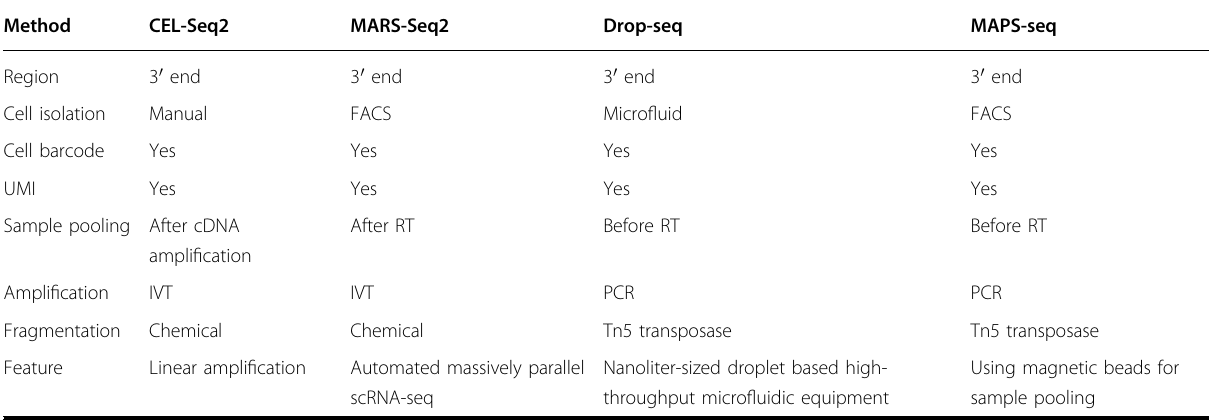
Table 1 Comparison of MAPS-seq with other representative scRNA-seq methods.